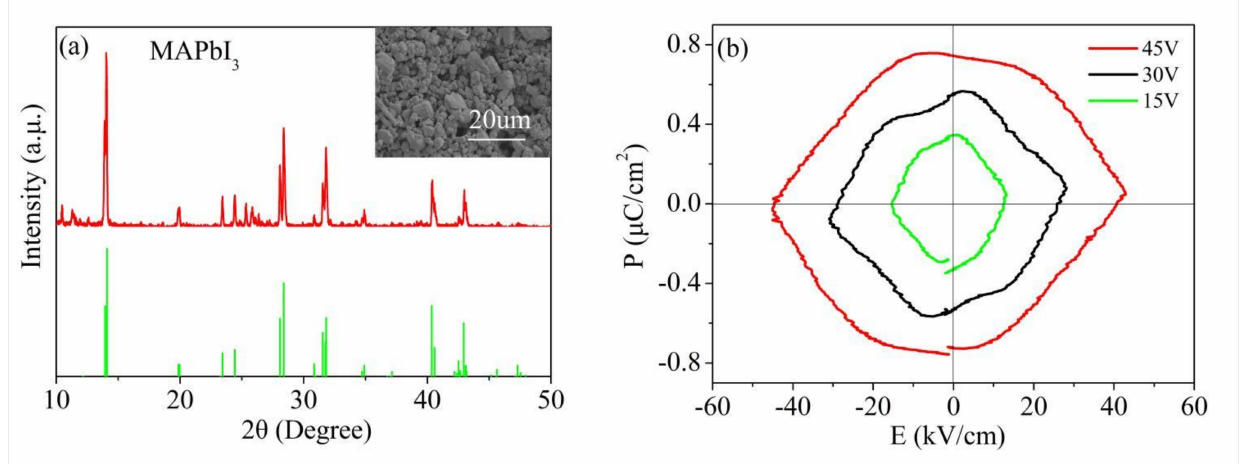
Figure 4. ( a ) XRD pattern and SEM image of MAPbI 3 powder; and ( b ) P-E loops of MAPbI 3 film measured at the frequency of 10 Hz under the voltage of 15, 30, and 45